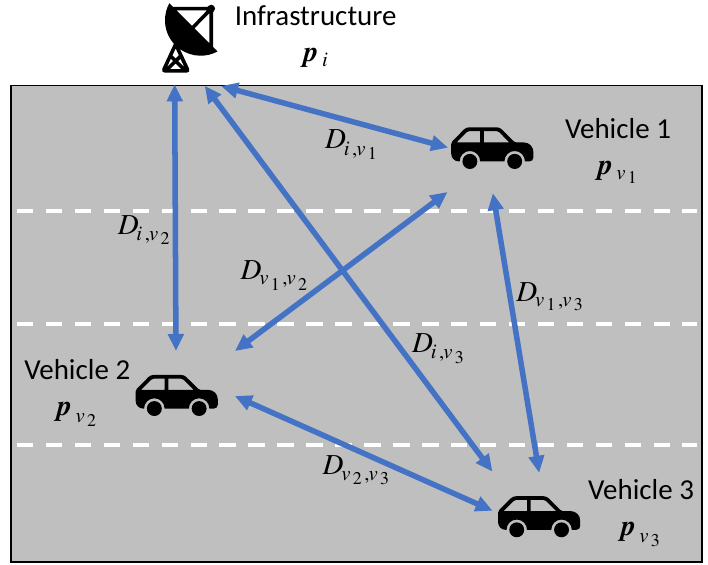
Figure 1. A possible scenario of the vehicle-to-everything (V2X)